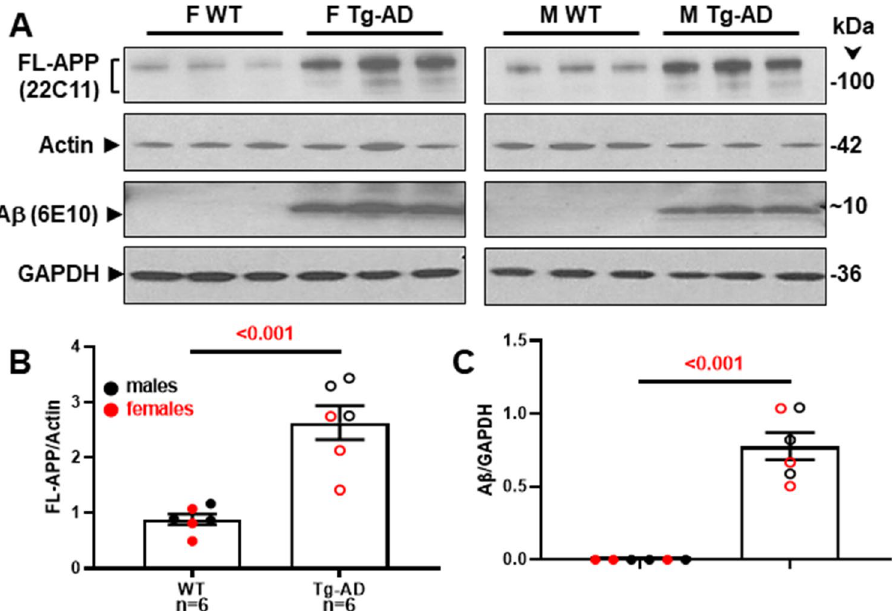
Figure 6. Tg-AD rats show enhanced FL-APP and Aβ peptide levels in the hippocampus at 9-months of age. ( A ) FL-APP (top panels) and Aβ levels (third panels from the top) were assessed by western blot analysis in whole left hippocampal (combined ventral and dorsal) homogenates from 9-month WT and Tg-AD female (F, 3 of each genotype) and male (M, 3 of each genotype) rats. Actin (second panels from the top) and GAPDH (bottom panels) detection served as the respective loading controls. FL-APP ( B ) and Aβ ( C ) levels were semi-quantified by densitometry. Data represent the percentage of the pixel ratio for FL-APP and Aβ over the respective loading controls for Tg-AD compared to WT (value of one). Values are means ± SEM from 6 rats per genotype (males and females combined). Significance (p values shown on graphs) was estimated by an unpaired one-tail t-tests with Welch’s corrections. There was no significant difference between males and females for both genotypes. The tissue samples used to detect each protein and their respective control were derived from the same experiment and analyzed on the same gel/blot. Blots were processed in parallel. The original/uncropped blots for each detection are provided in the Supplementary information file with each blot labeled according to the protein